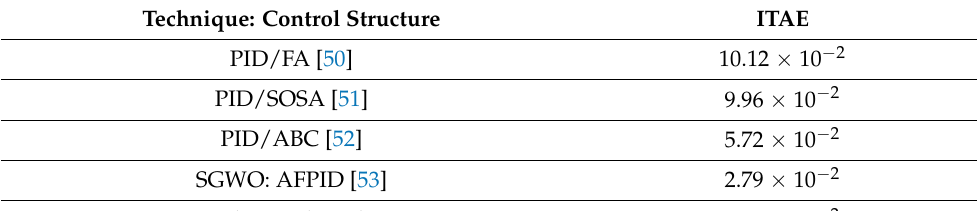
Table 8. Objective function values for the different controllers for 2nd test system.